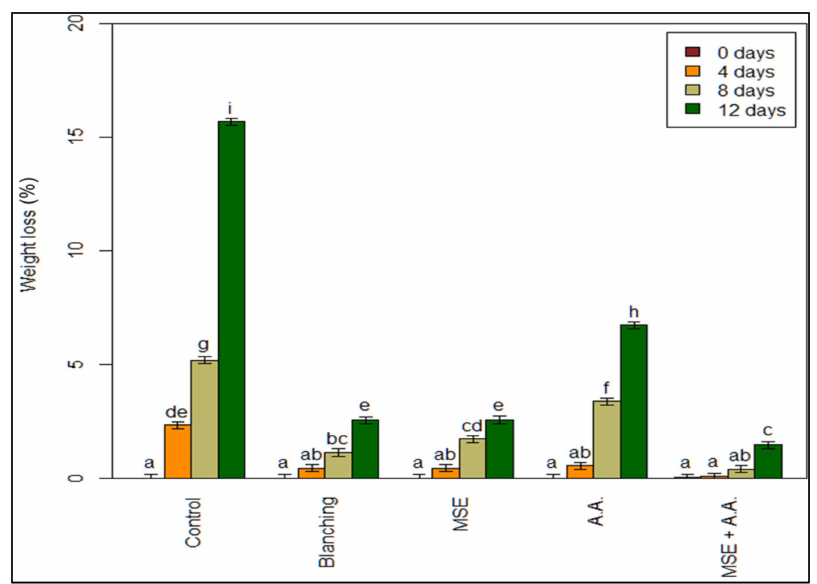
Figure 1. Effect of ascorbic acid (AA), mucilage seed extract (MSE), MSE + A.A, and blanching on weight loss (%) of fresh-cut potato strips. (Means with the same CLD letter are not statistically significantly different. Letters come from holm-corrected multiple comparisons across all times and treatments).